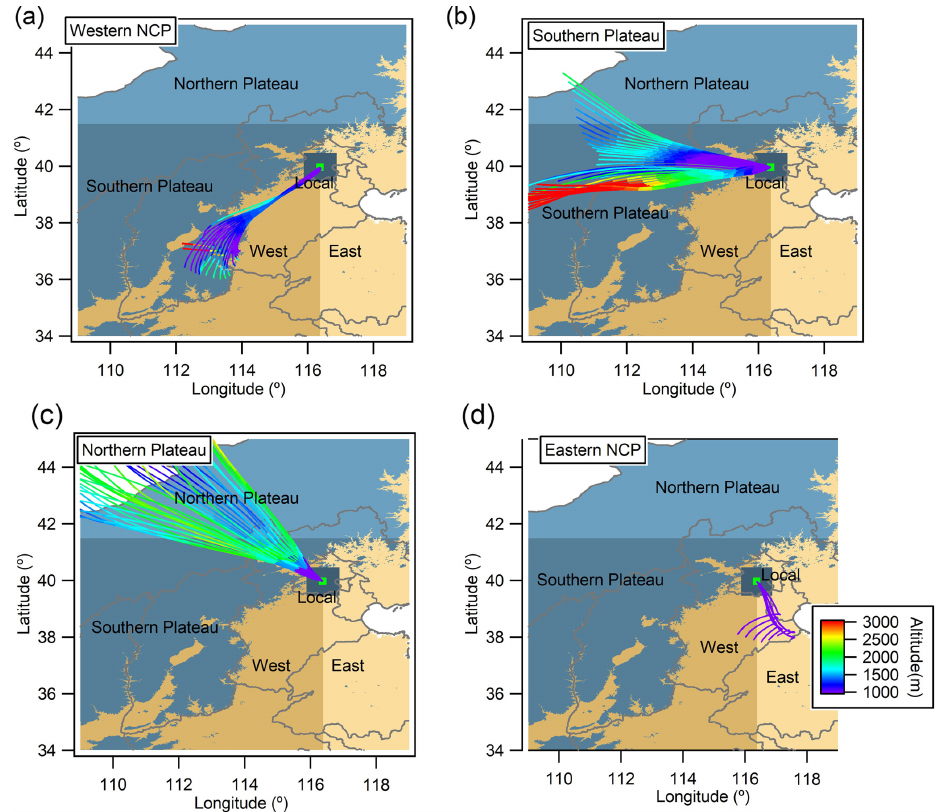
Figure 2. Classified air mass origins based on back-trajectory analysis: Western NCP, Southern Plateau, Northern Plateau and Eastern